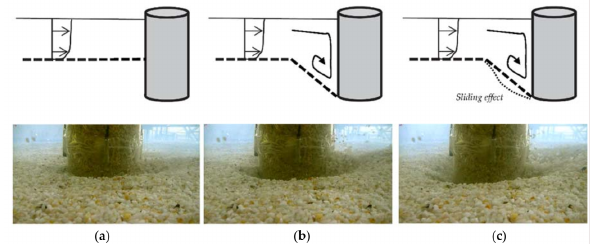
Figure 1. Scouring process around a pier structure. A laboratory experiment was conducted in the Hydraulics Laboratory of the Department of Civil Engineering, Dokuz Eylul University, Turkey [1]. ( a ) Initial state before the scour occurred. ( b ) Local scour hole that occurred around the pier. ( c ) Occurrence of the sliding effect in the front of the scour hole when the local bed slope was higher than the angle of